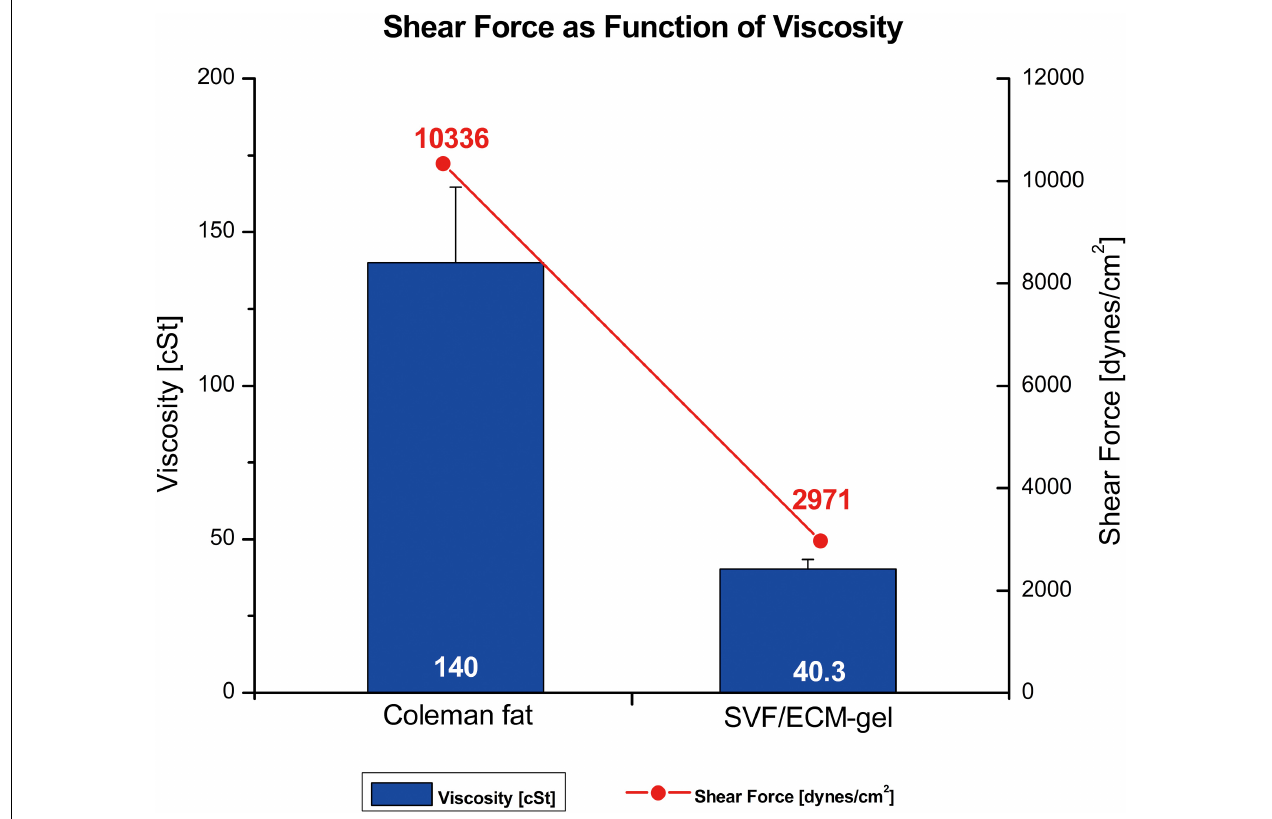
FIGURE 4 | Relationship between shear force (line) and kinematic viscosity (columns) of different fat types. The SVF/ECM gel was obtained by mechanical isolation of the initial Coleman fat through the application of shear force.